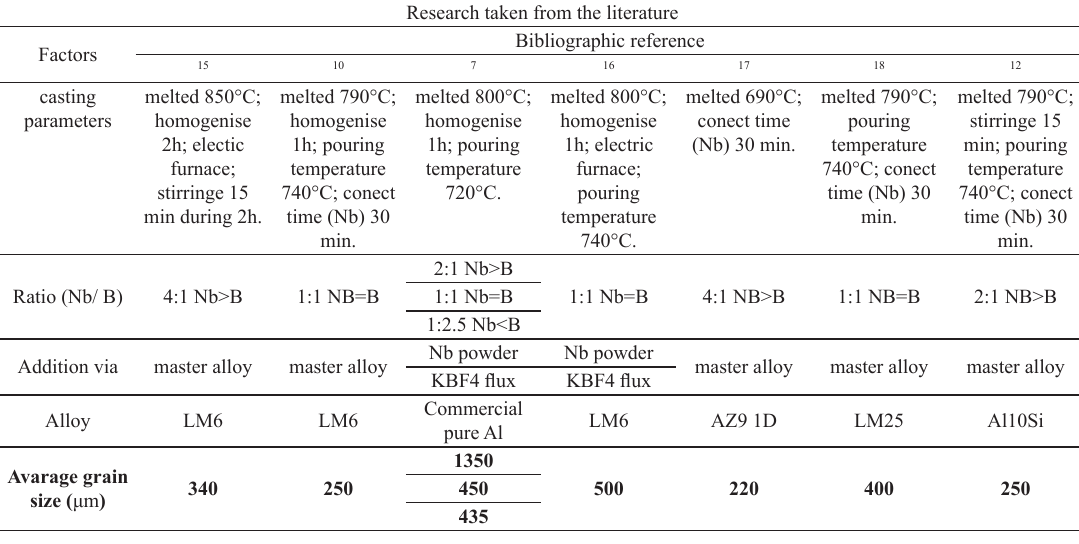
Table 1. Comparative summary of studies.